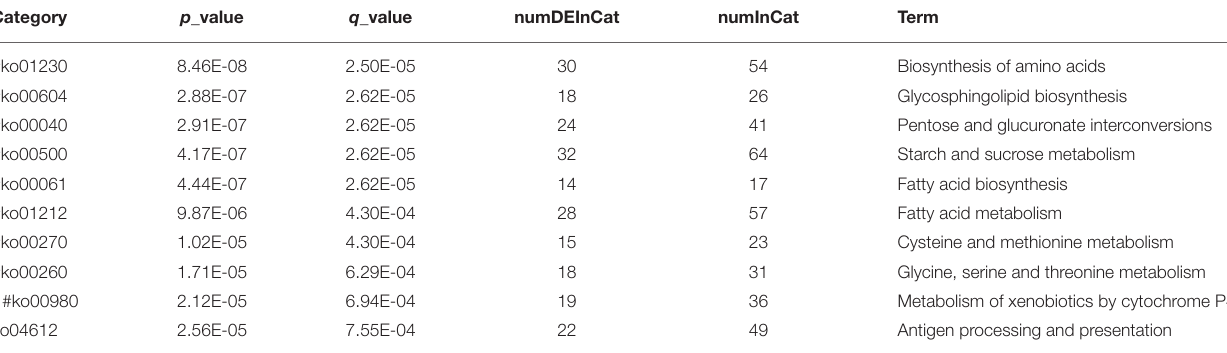
TABLE 2 | Top-10 pathways DEGs involved in based on KEGG enrichment analysis.